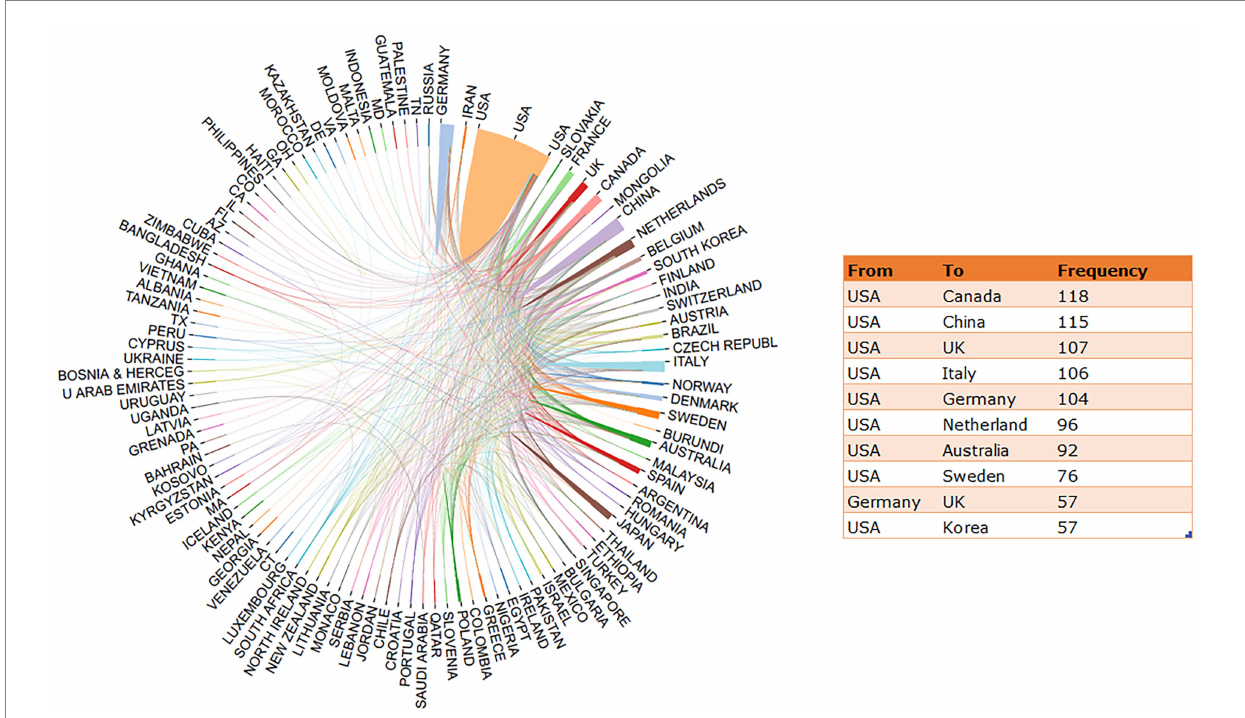
FIGURE 3 The collaborative research between countries on heart failure and depression.